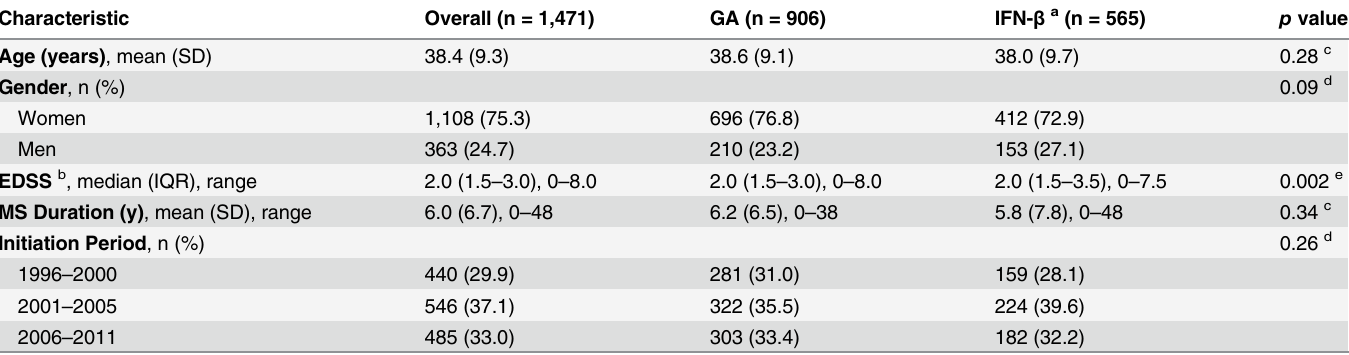
Table 1. Characteristics of the study cohort at the index date overall and by the initial DMT prescribed.